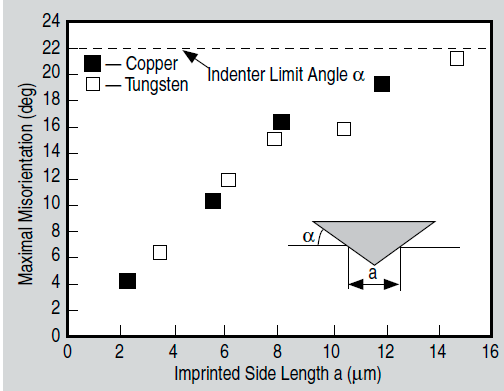
Figure 25. Maximum misorientation angle measured along the flanks of the indent for different sized Vickers indents into fcc copper (closed squares) and bcc tungsten (open squares) [82,83]. Reproduced with permission from D. Kiener et al., JOM; published by Springer, 2009. Meyer’s law is another widely used method to describe ISE. For the indenters which have ideal geometry, the relationship between the test load and the resultant indentation diagonal length curve could be obtained from